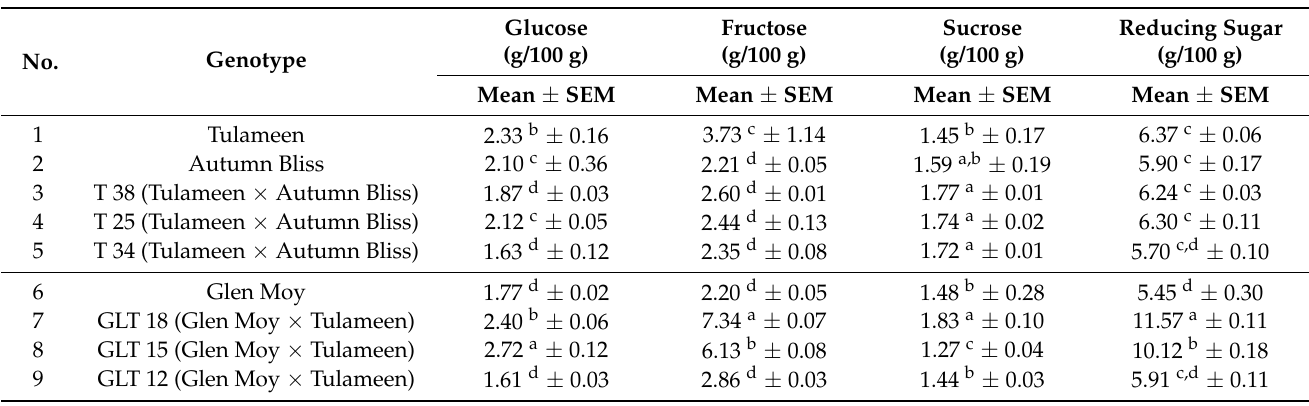
Table 4. The average values for glucose, fructose, sucrose, and reducing sugar in the fruits of 24 raspberry genotypes (14 promising selections (clones), their parents, and Glen Ample cultivar as